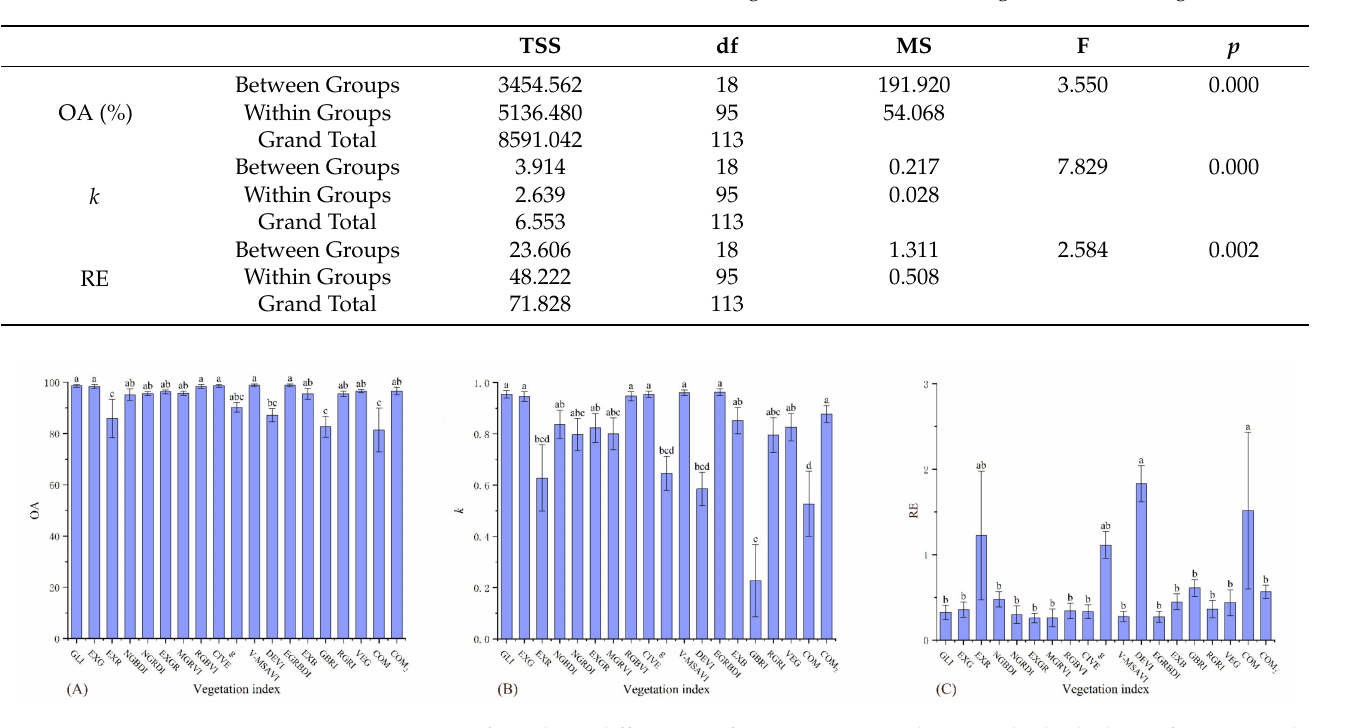
Figure 3. OA, k , and RE differences of 19 vegetation indices on the high desertification grade. ( A ) figure is the result of one-way analysis of variance for OA. ( B ) figure is the result of one-way analysis of variance for k . ( C ) figure is the result of one-way analysis of variance for RE. Values with the same lowercase letters within vegetation indices are not significantly different at p <